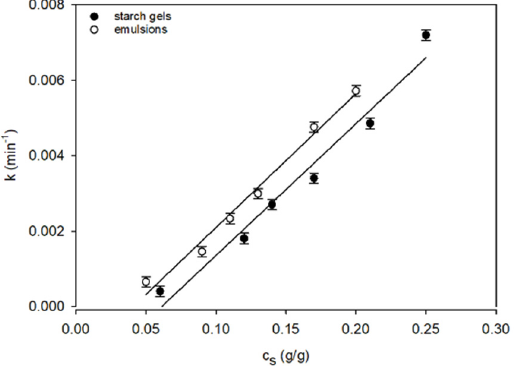
Figure 2. The concentration-dependent relationships of the time constant k of the starch gels and starch–fat emulsions. The values are expressed as means ± SD ( n = 3).